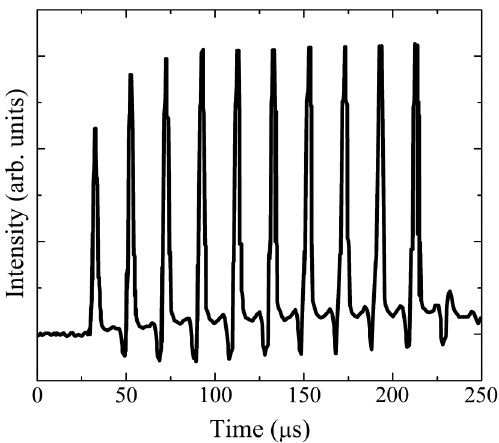
FIG. 12. Output pulse train from a BBO PC. There is no ringing, but the first few pulses have lower